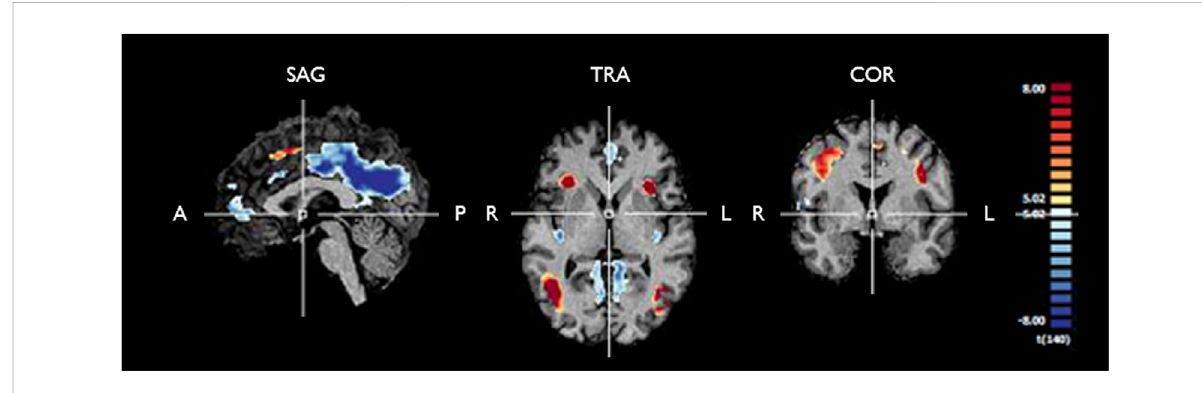
FIGURE 3 Functional maps generated from RFX GLM analysis of the fMRI response to any stimulation condition during the block design experiment for controls and T2DM patients. The map is corrected for multiple comparisons (p Bonferroni < 0.05). One can see signi fi cant positive signal change (yellow/red) and negative signal change (blue) in several clusters, which are further described in Tables 2, 3. We used these ROIs to extract the fMRI BOLD signal for further analysis of the HRF in each group. SAG, sagittal; TRA, transverse; COR, coronal; A, anterior; P, posterior; R, right; L,